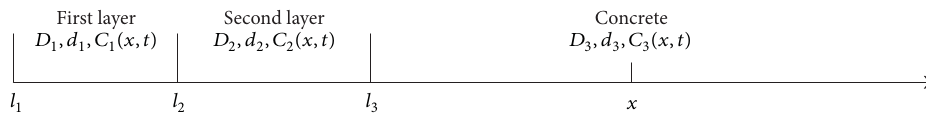
Figure 1: Concrete with two layers of